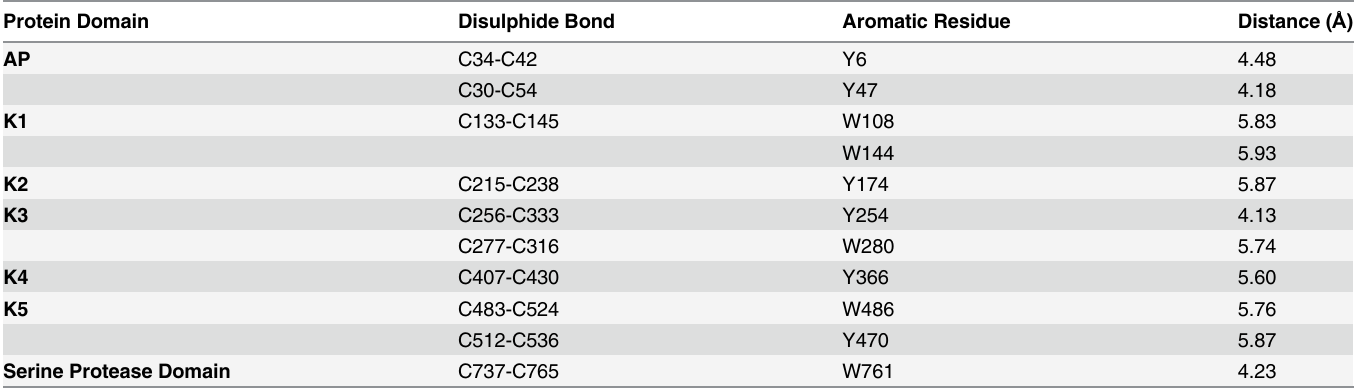
Serine Protease Domain 4.23 The shortest distances ( < 6 Å ) between atoms of each pair of elements (Trp, Tyr and disulphide bonds) were considered. For Trp and Tyr residues, only the atoms belonging to the indole and benzene rings were considered.